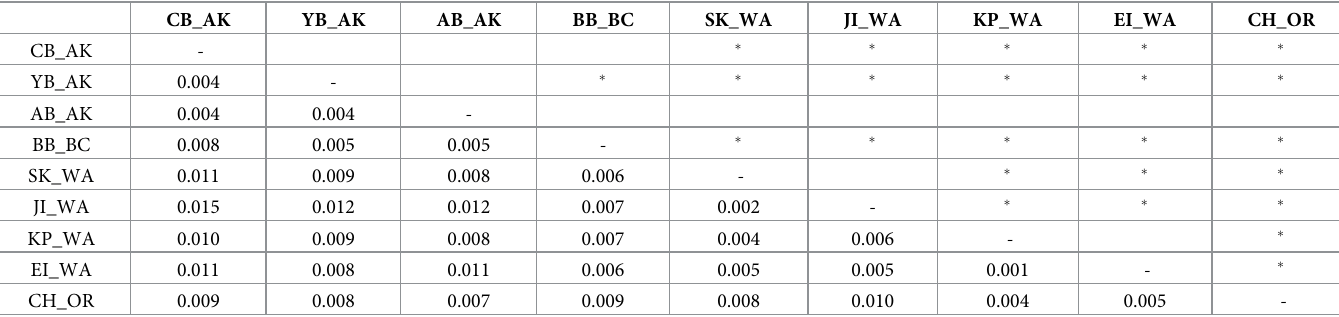
Table 4. Pairwise F ST and genic differentiation test results.